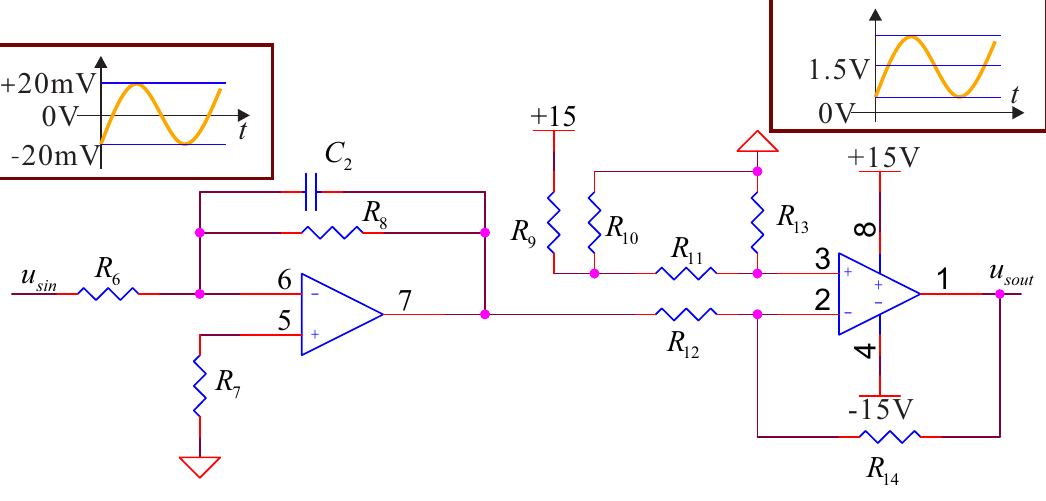
Figure 9. The small signal extracting system in the detecting